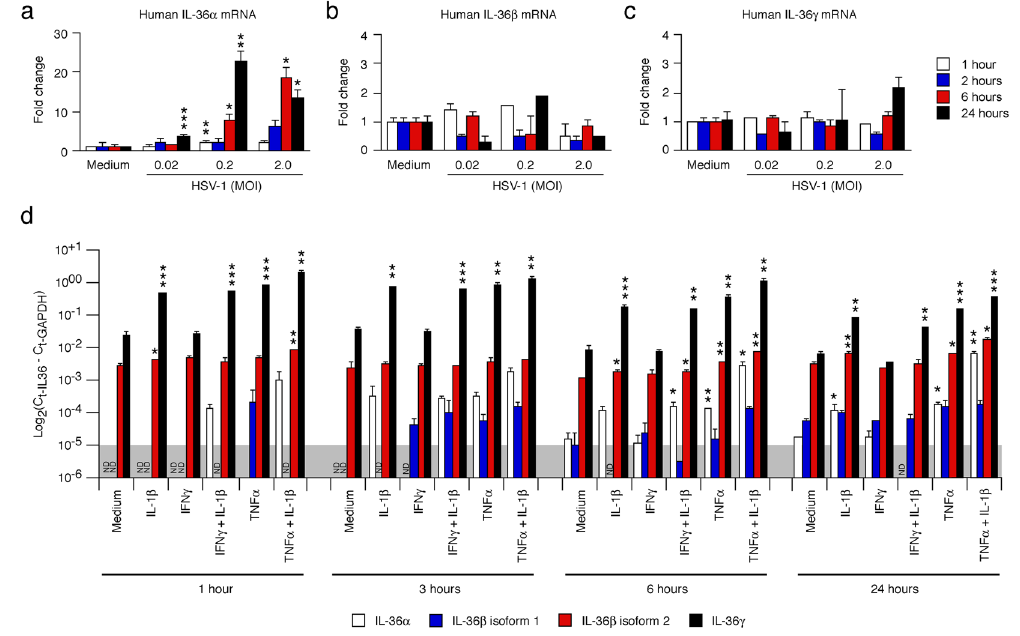
Figure 10. Human IL-36 mRNAs are differentially induced in response to HSV-1 infection and cytokines. Human primary keratinocytes were infected with HSV-1 ( a – c ) or treated with medium only, 10 ng/ml IL- 1 β , 20 ng/ml IFN γ and/or 50 ng/ml TNF α ( d ) as indicated. IL-36 α , IL-36 β (isoform 1 and 2 in d ) and IL-36 γ mRNA levels were determined by real-time PCR and standardized against GAPDH levels. ( a – c ) Fold changes in IL-36 expression were calculated against medium only treated samples at the same time-point. ( d ) Proportional expression of IL-36 levels are graphed as log 2 (C t-IL-36 − C t-GAPDH ). Representative data from one of at least three independent experiments is shown as means ± SD. * p < 0.05 (compared to medium only at the same time- point); ** p < 0.01; *** p <